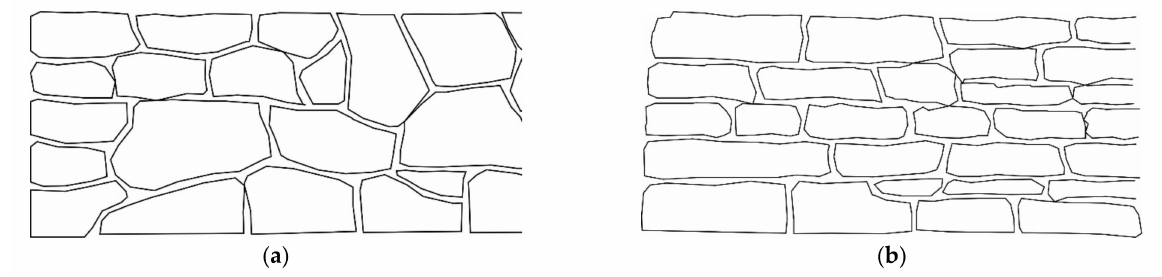
Figure 1. Front view of piled ( a ) and stacked ( b ) stone pitching types.